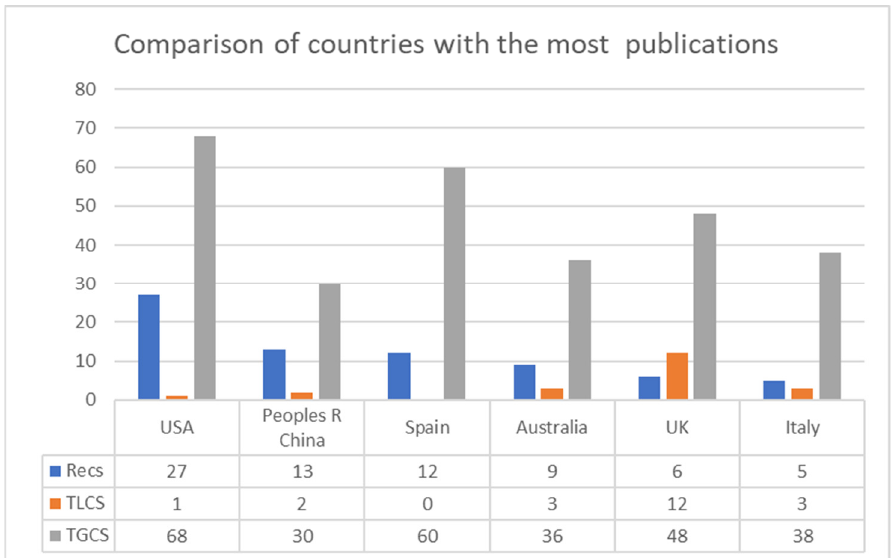
8 of 25 Figure 3. Number of publications by institution ( ≥ 2 Recs; ≥ 12 TGCS). Note: Recs is the number of articles, TLCS is the local citation score and TGCS is the global citation score. 3.1.4. Countries